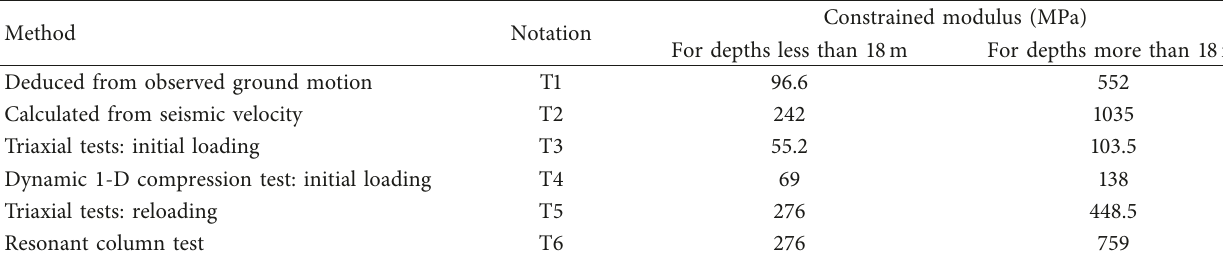
Table 3: Constrained modulus of playa silt at Frenchman Flat [4].